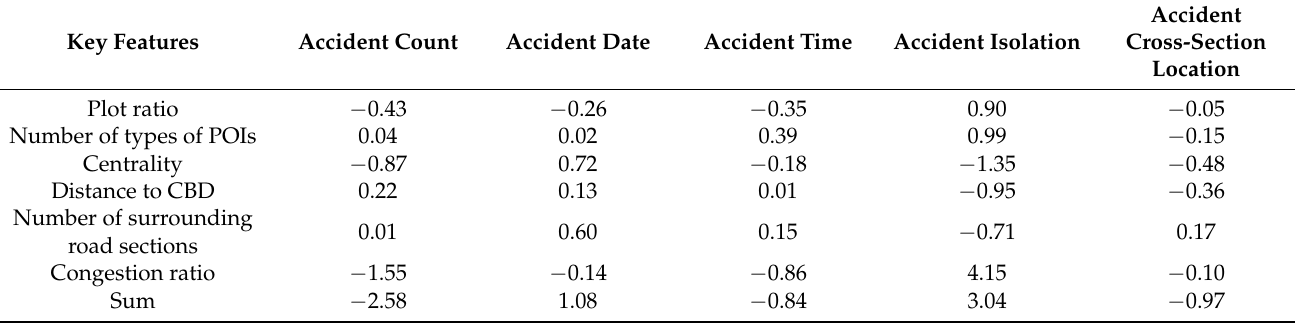
Table 8. W f ,1&2 after training.